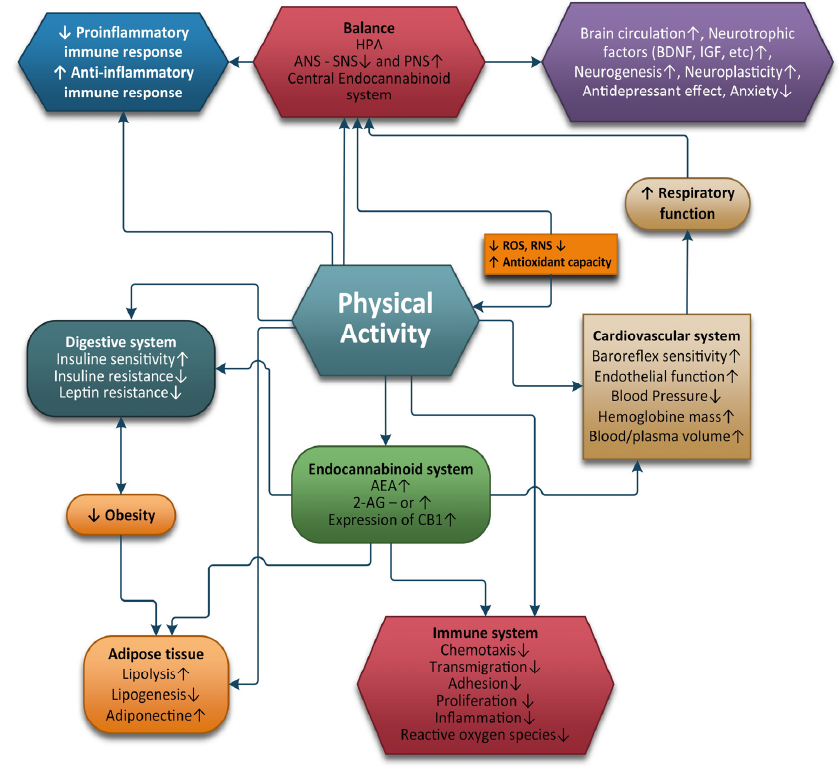
Figure 2. Positive effects of physical activity.